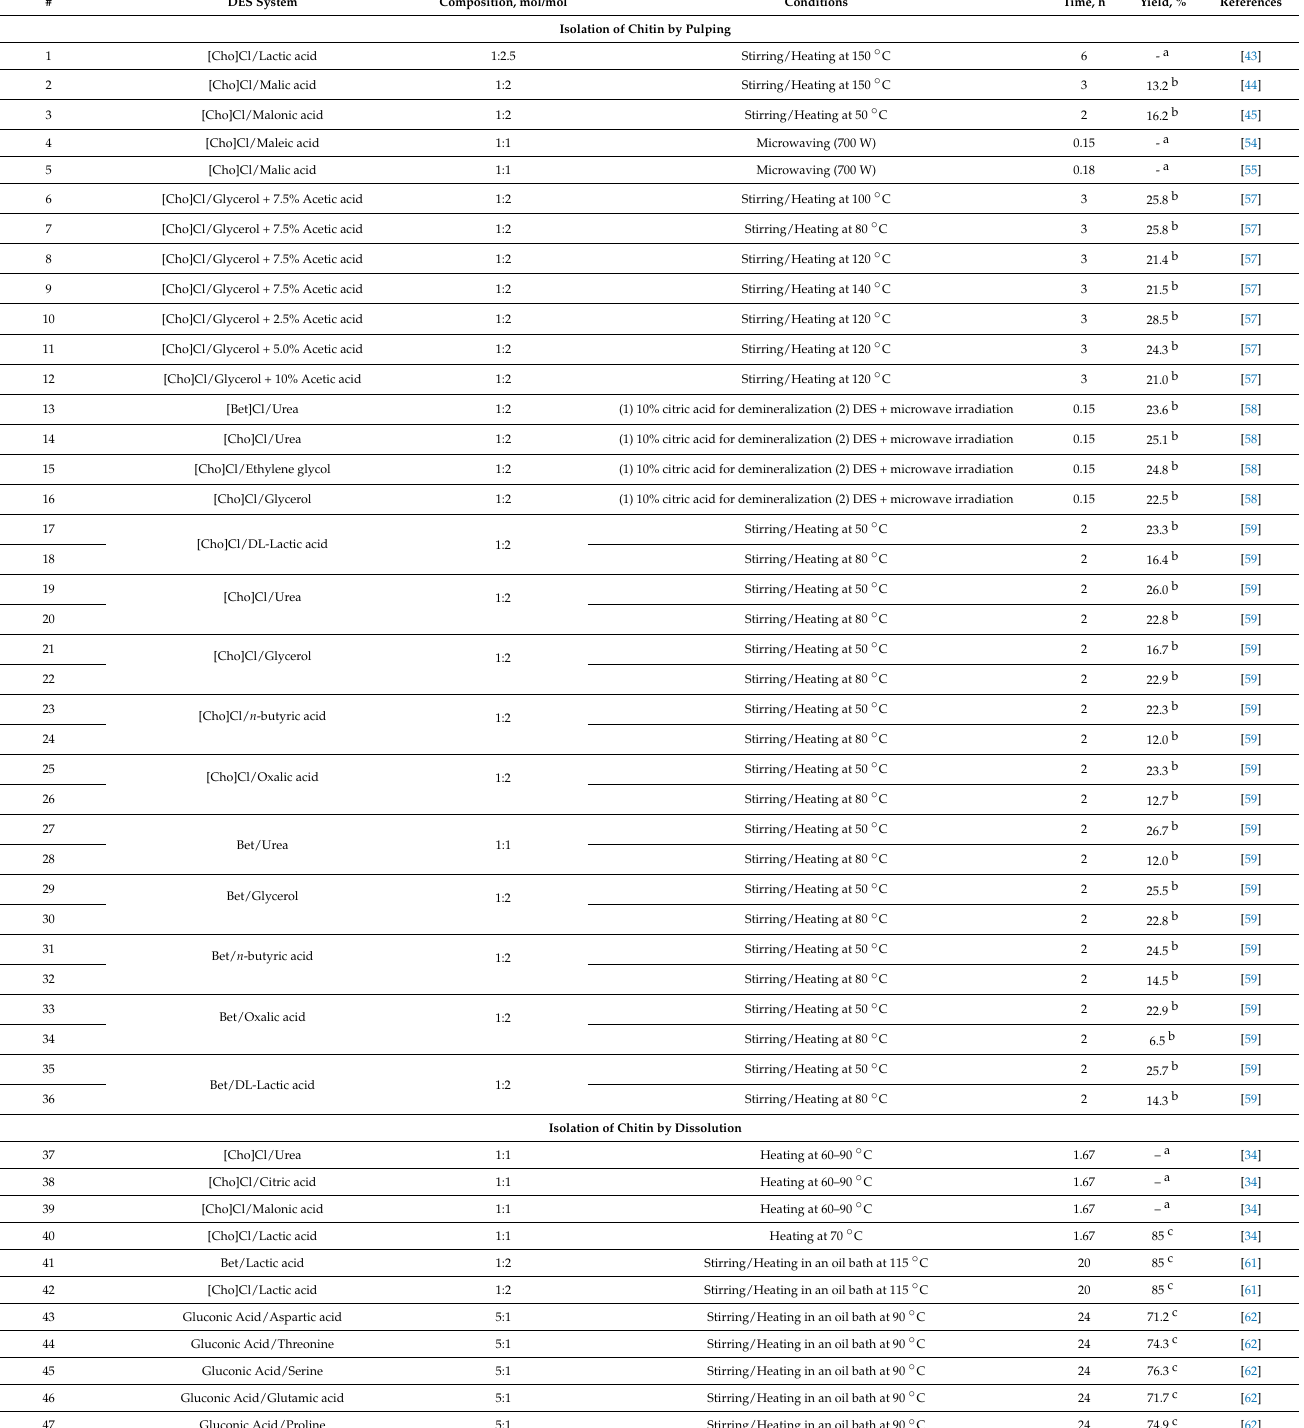
Table 1. Deep eutectic systems reported for chitin recovery from